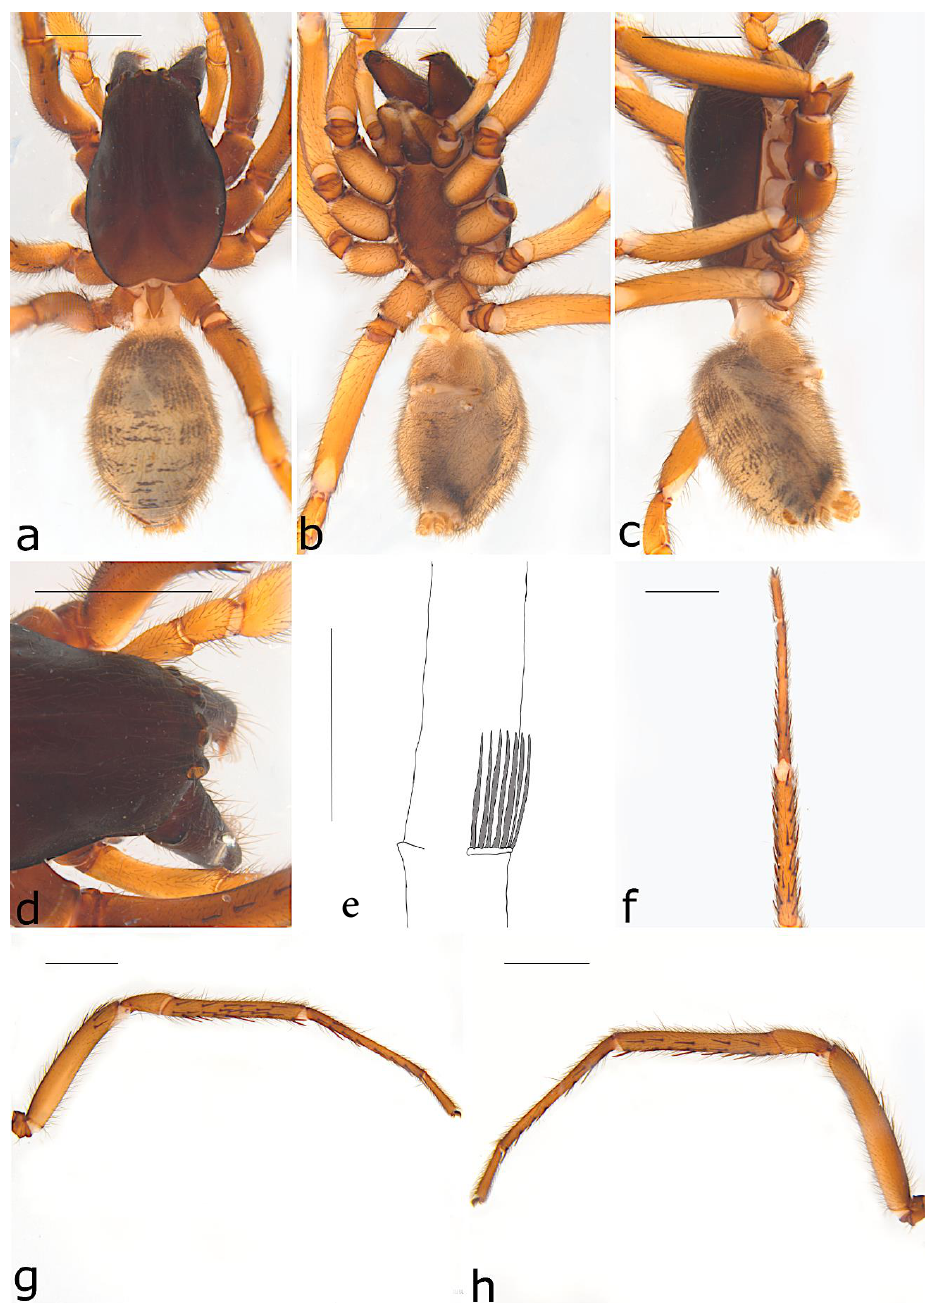
Figure 11. Ariadna otwayensis sp. nov. ♂ holotype (MV K-4985) from the Otway Ranges (Vic): ( a ) habitus, dorsal view; ( b ) same, ventral view; ( c ) same, lateral view; ( d ) eyes, dorsal view; ( e ) left metatarsus IV, preening comb, retrolateral view, macrosetae of preening comb shaded grey for clarity; ( f ) left leg I, ventral view; ( g ) same, prolateral view; ( h ) same, retrolateral view. Scale bars ( a – d ) = 2 mm, ( e ) = 0.5 mm and ( f – h ) = 2 mm.